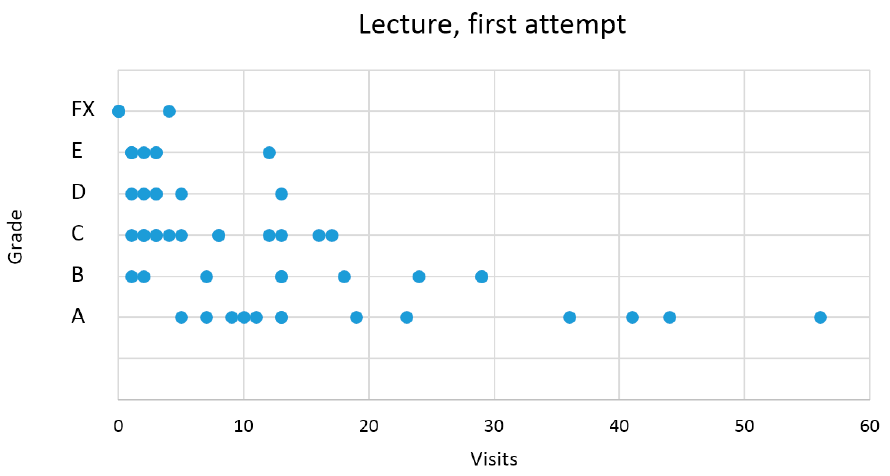
Figure 14. Grades based on visits in “Lecture”material on the first attempt.